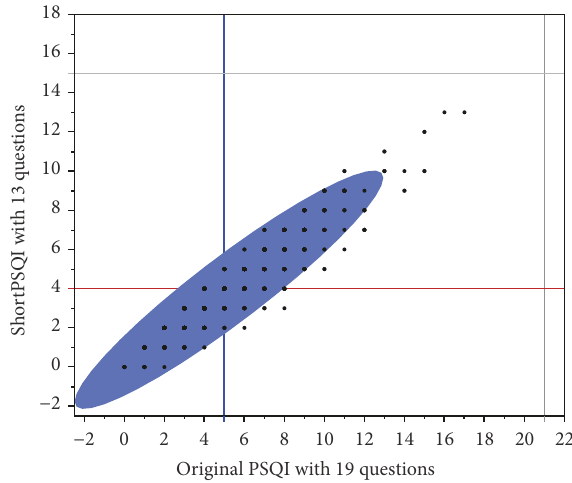
Figure 2: Spearman correlation of 0.94 ( 𝑝 < 0.0001 ) was detected between scores of original PSQI and shortened survey. Grey lines represent maximal possible global score in original PSQI (21) and “shortPSQI” (15). Blue vertical line represents cut-off 5 on PSQI; all who had more than 5 were assigned as poor sleepers. Red horizontal line represents cut-off point of 4 in shortPSQI; all students above the line were defined as poor sleepers. Table 1: Global PSQI score of the original and the “shortPSQI.” Survey (𝑛 = 1246)